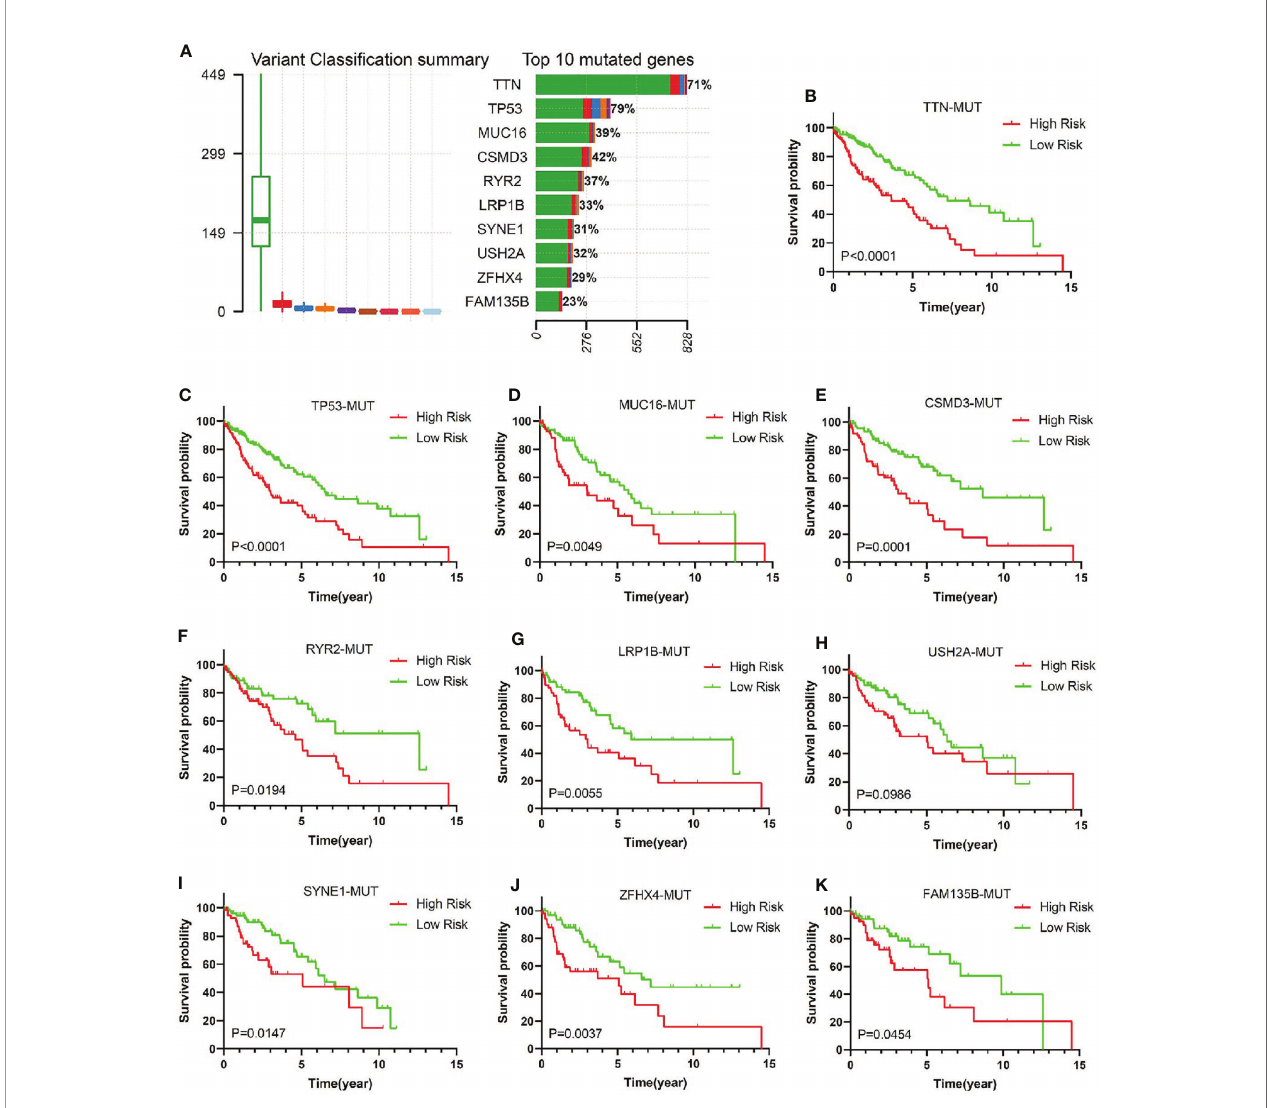
FIGURE 6 | The relationship between risk score and common mutant genes in early stage LUSC patients. (A) The variant classi fi cation summary and top 10 mutated genes in LUSC. Kaplan – Meier curves of early stage LUSC patients with TTM mutation (B) , TP53 mutation (C) , MUC16 mutation (D) , CSMD3 mutation (E) , RYR2 mutation (F) , LRP1B mutation (G) , USH2A mutation (H) , SYNE1 mutation (I) , ZFHX4 mutation (J) , or FAM135B mutation (K) based on risk